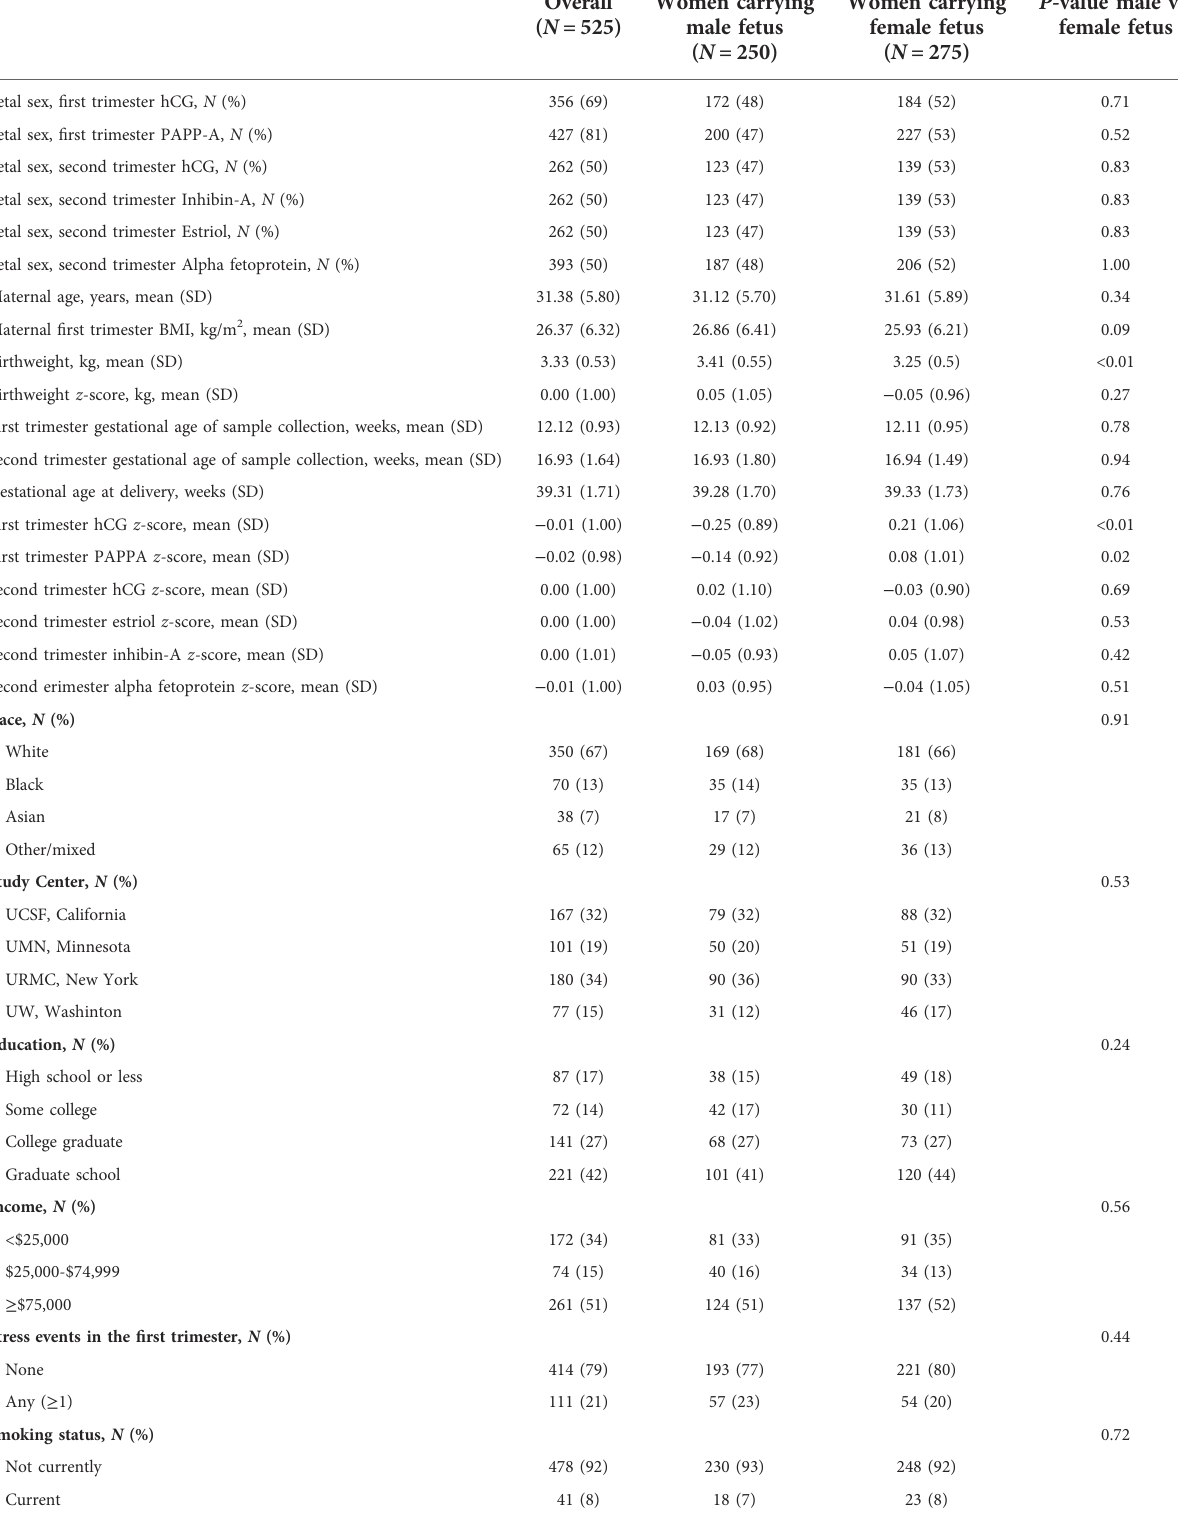
TABLE 1 Demographics of study subjects in the infant development and environment study (TIDES), 2010 –